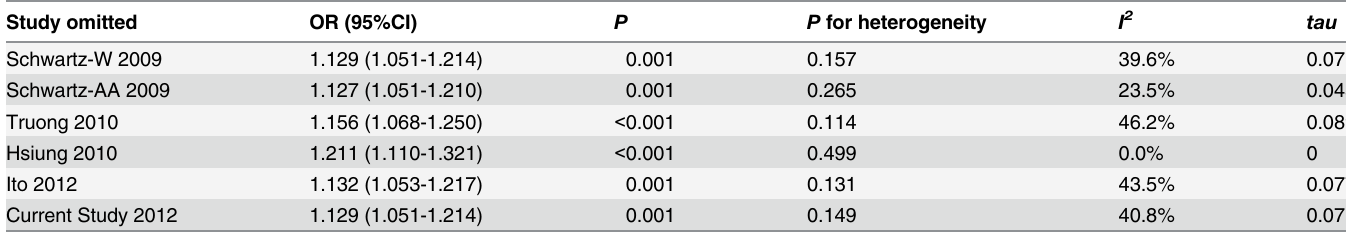
Table 5. Sensitivity analysis of dominant